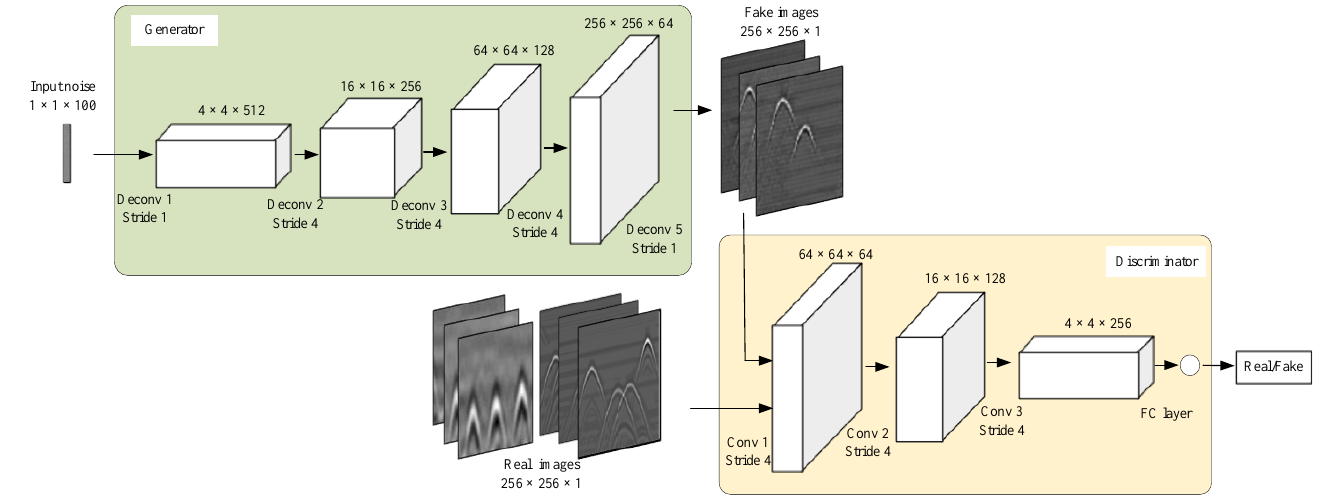
Figure 2. WGAN structure for generating GPR images.